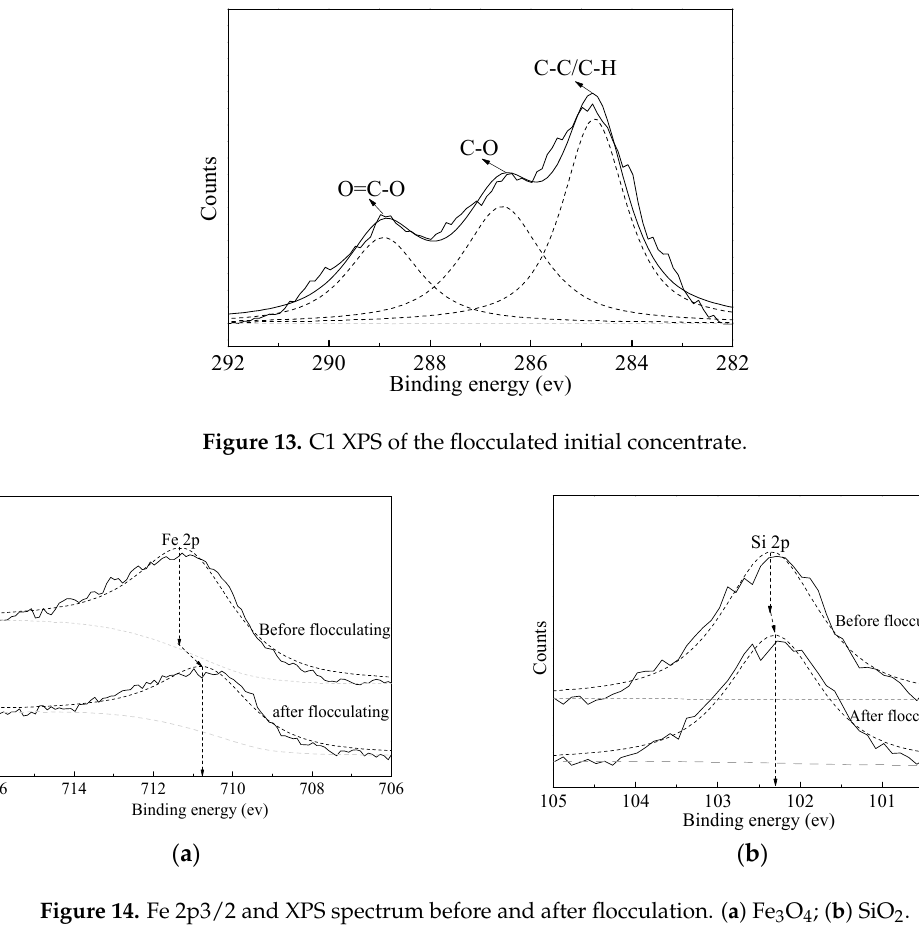
Figure 12. Infrared spectral analysis.